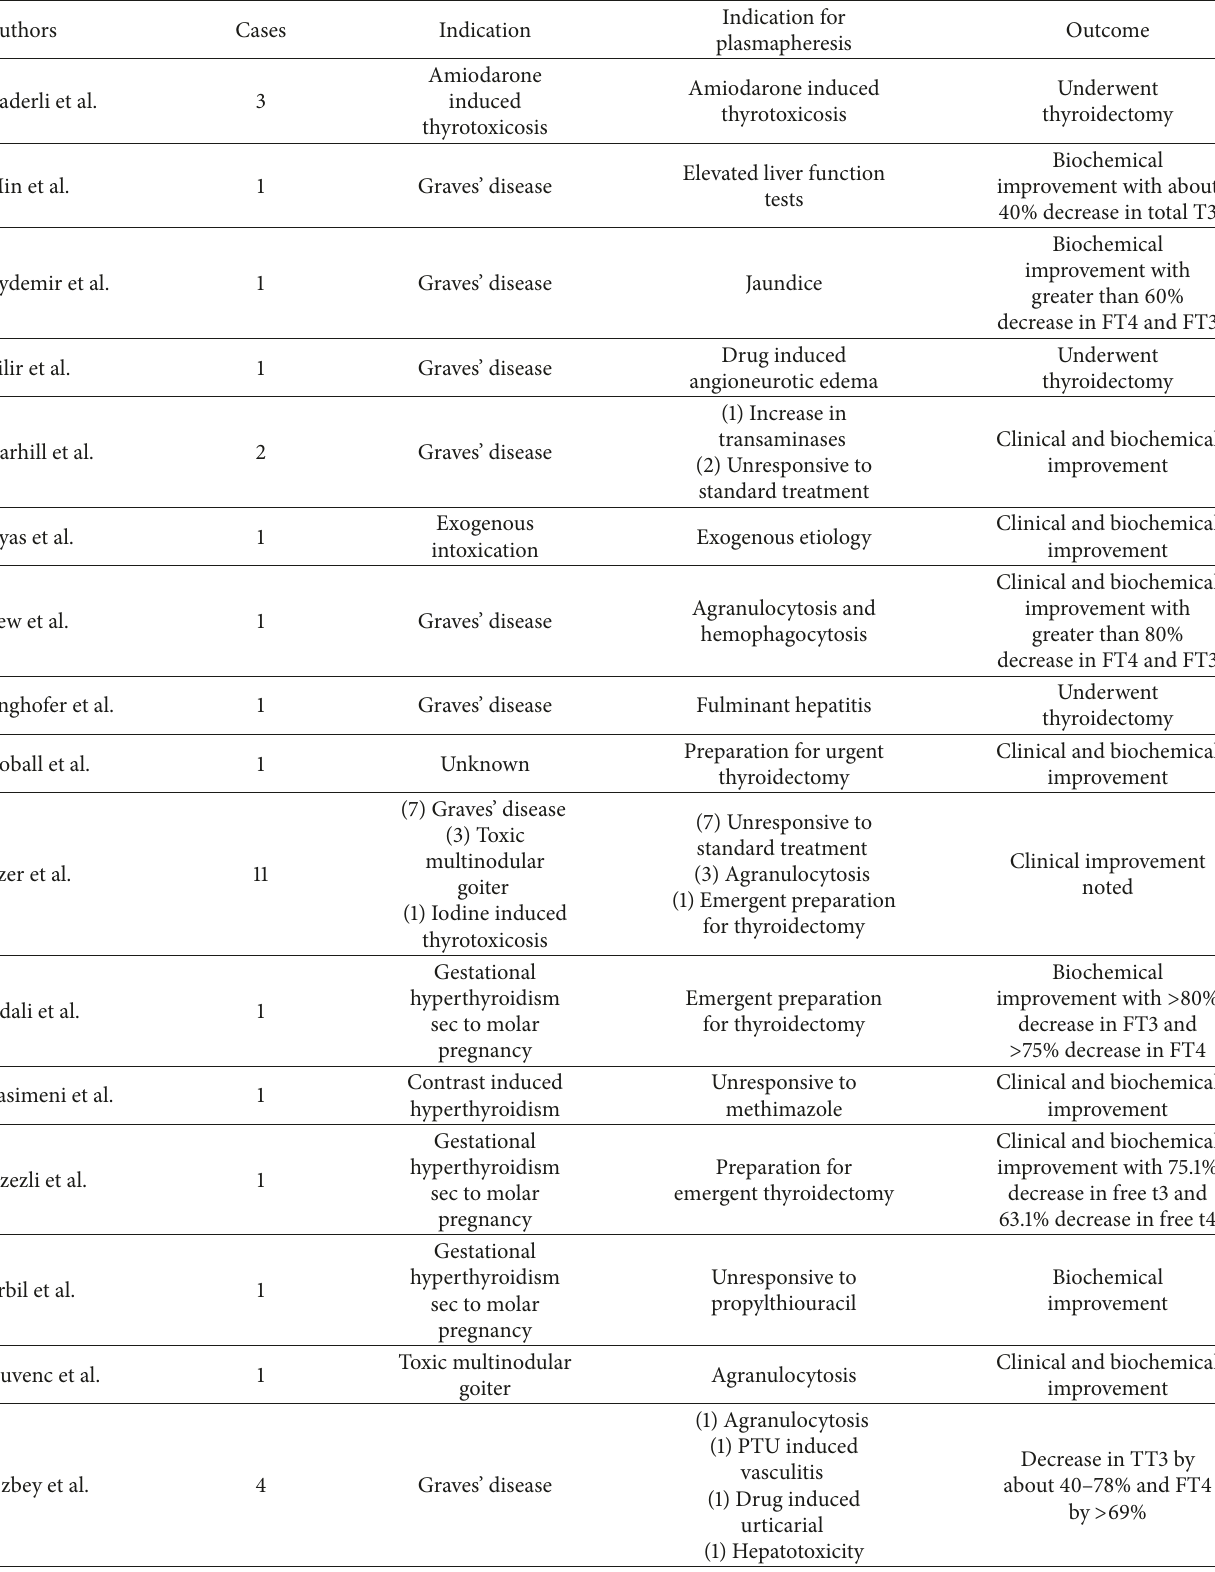
Table 2: Literature